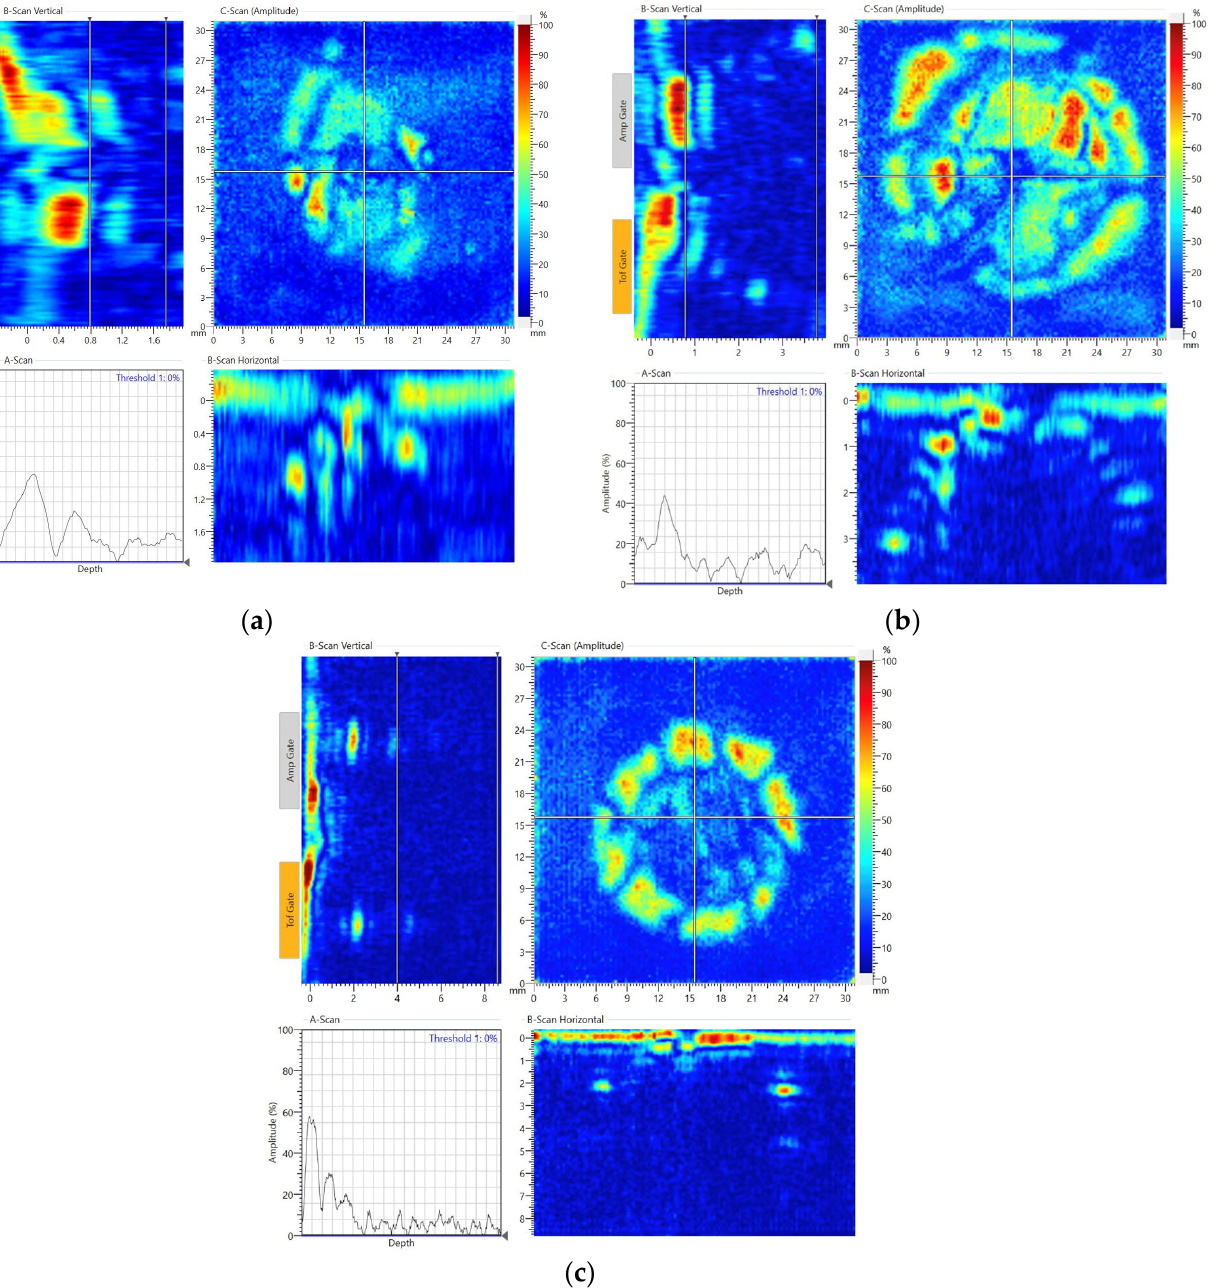
Figure 14. The C-scan results of the impact damage at 15 J for the 2 mm thick panel ( a ), 20 J for the 4 mm thick panel ( b ) and 57 J for the 9 mm thick panel ( c ).